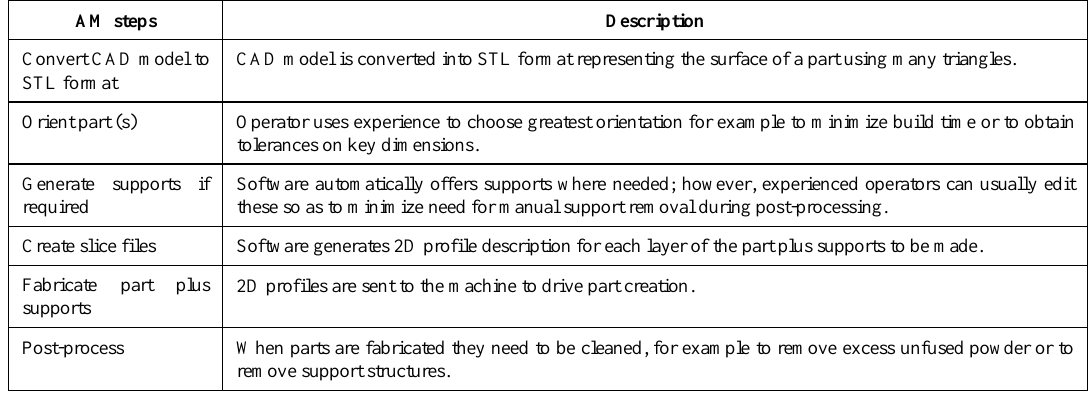
Table 1. Generic process sequence for AM